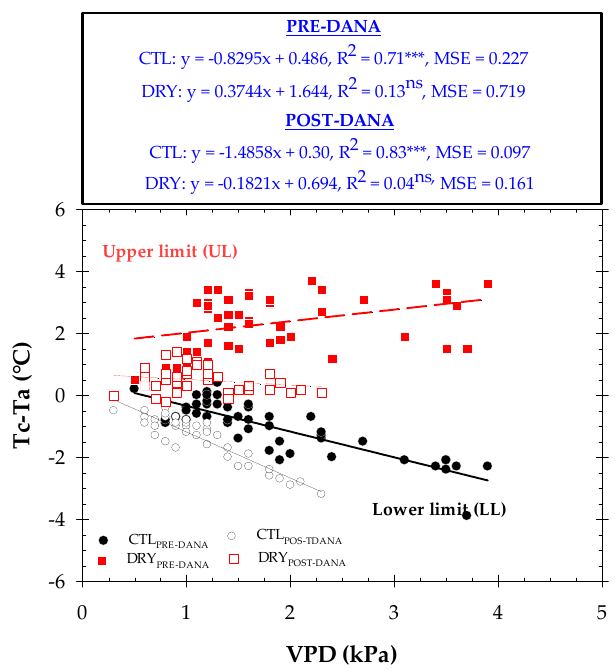
Figure (cid:561) 5. (cid:561) Relationship (cid:561) between (cid:561) Tc (cid:442) Ta (cid:561) (°C) (cid:561) and (cid:561) measured (cid:561) VPD, (cid:561) averaging (cid:561) from (cid:561) 08:00 (cid:561) to (cid:561) 10:00 (cid:561) GTM (cid:561) Figure 5. Relationship between Tc − Ta ( ◦ C) and measured VPD, averaging from 08:00 to 10:00 GTM + 0. + (cid:561) 0. (cid:561) for (cid:561) CTL (cid:561) (full (cid:442) irrigated) (cid:561) and (cid:561) DRY (cid:561) (non (cid:442) irrigated) (cid:561) treatments. (cid:561) Each (cid:561) point (cid:561) corresponds (cid:561) to (cid:561) daily (cid:561) for CTL (full-irrigated) and DRY (non-irrigated) treatments. Each point corresponds to daily cloudless observations including PRE- and POST-DANA periods ( n = 125). ***: p < 0.001, ns: not